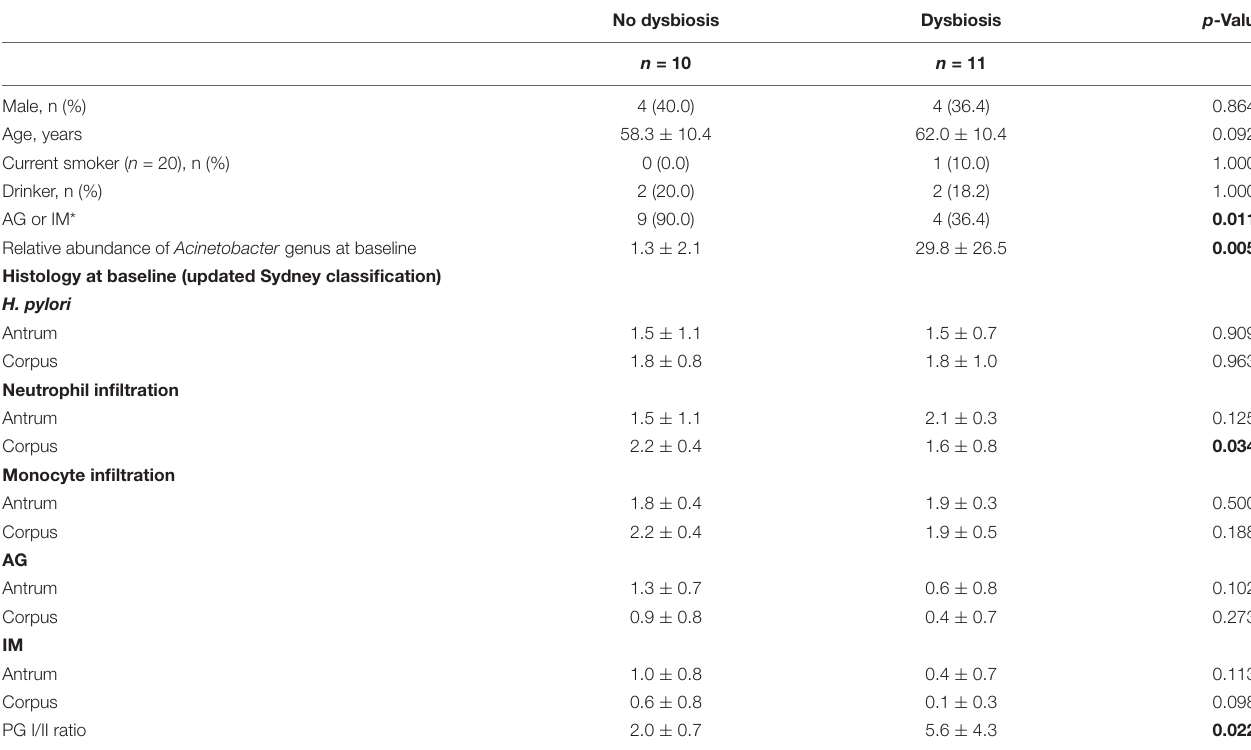
TABLE 2 | Comparison of clinical variables, microbiota composition, and histology between the no dysbiosis group ( n = 10) and the dysbiosis group ( n = 11) after successful H. pylori